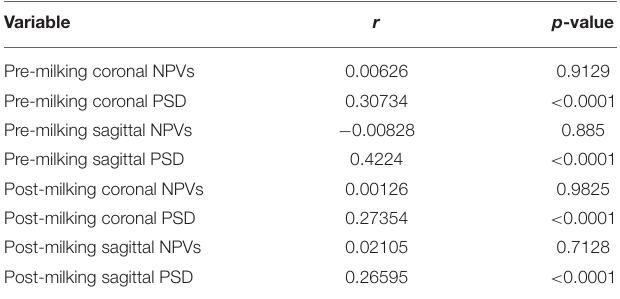
TABLE 5 | Descriptive statistics pre-milking sagittal PSD of the mammary gland in a single udder quarter using ANOVA analysis by SCC (54 test-day records for eight